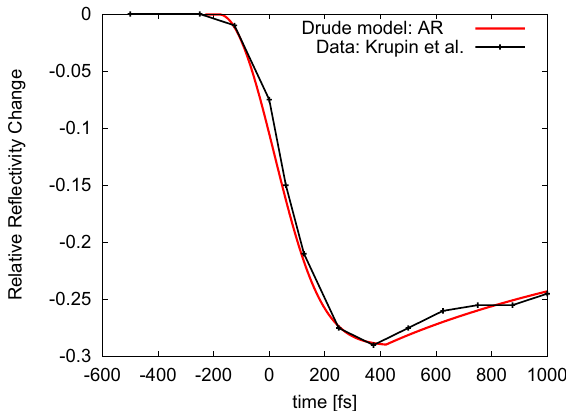
Figure 6. Relative change of reflectivity, ( R ( t ) − R equib )/ R equib in soft X-ray irradiated Si 3 N 4 recorded in the experiment by Krupin et al. 7 (Fig. 3 therein). The data were averaged over many single shots. FEL photon energy was 540 eV. Note that the XFEL pulse duration ( ∼ 50–150 fs FWHM) was not precisely measured in this experiment. Also, the time ’zero’ denotes here the time instant when the reflectivity starts to decrease. The probe pulse wavelength was (cid:31) = 800 nm. The published data reproduced from Ref. [8] are then compared to the results of our calculations in which only the Auger recombination (AR) was taken into